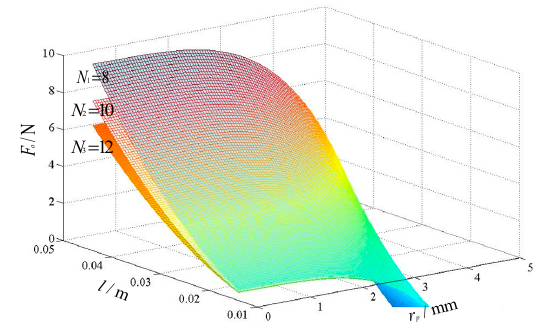
Figure 10. Influences of r p , l , and N on F o ( r = 0.02 m, R o = 0.015 m, x o = 0, y o = 0.03 m, E = 5 × 10 7 Pa, p o = 1.01 × 10 5 Pa, and p i = 0.8 p o ).